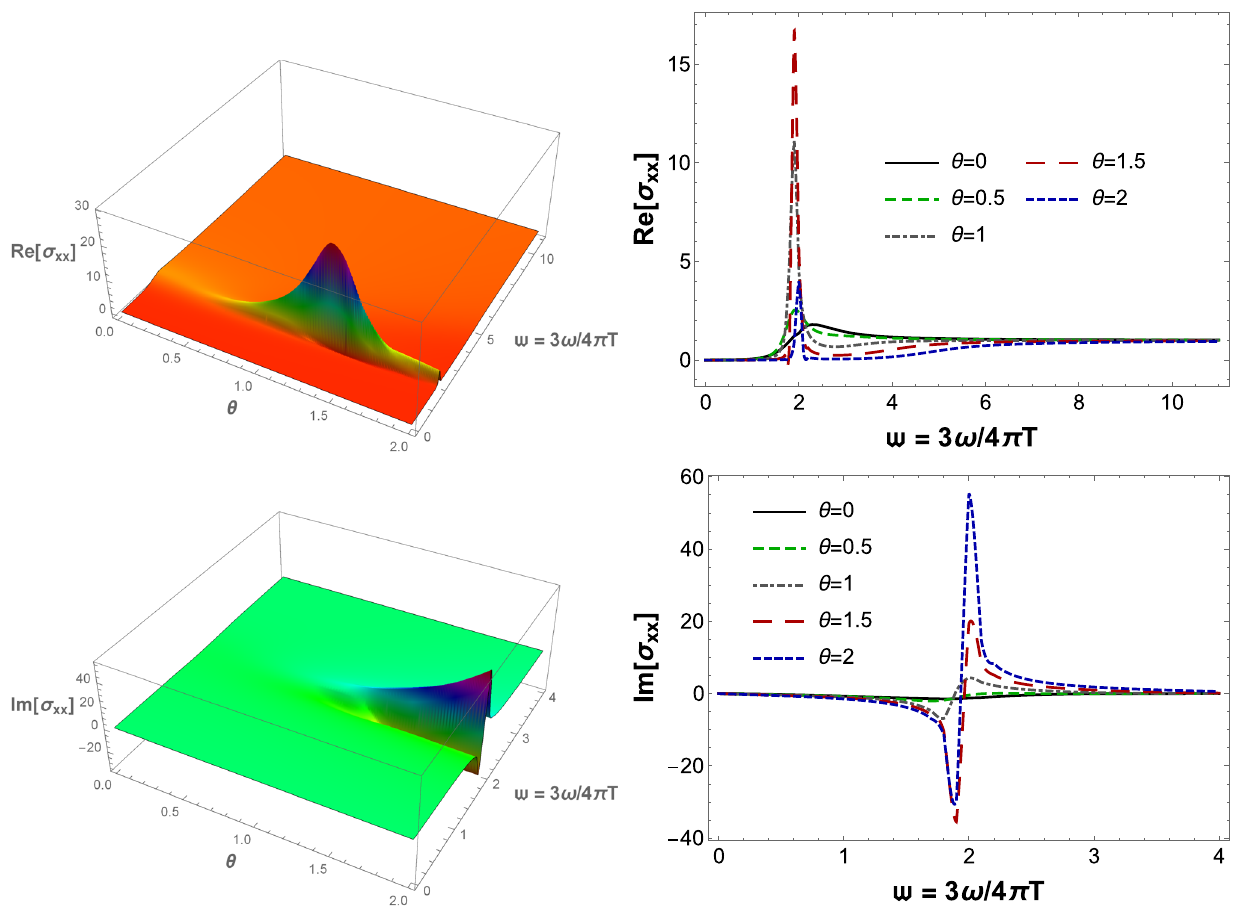
ing the characteristic mass scale (cid:12) of the bulk monopole